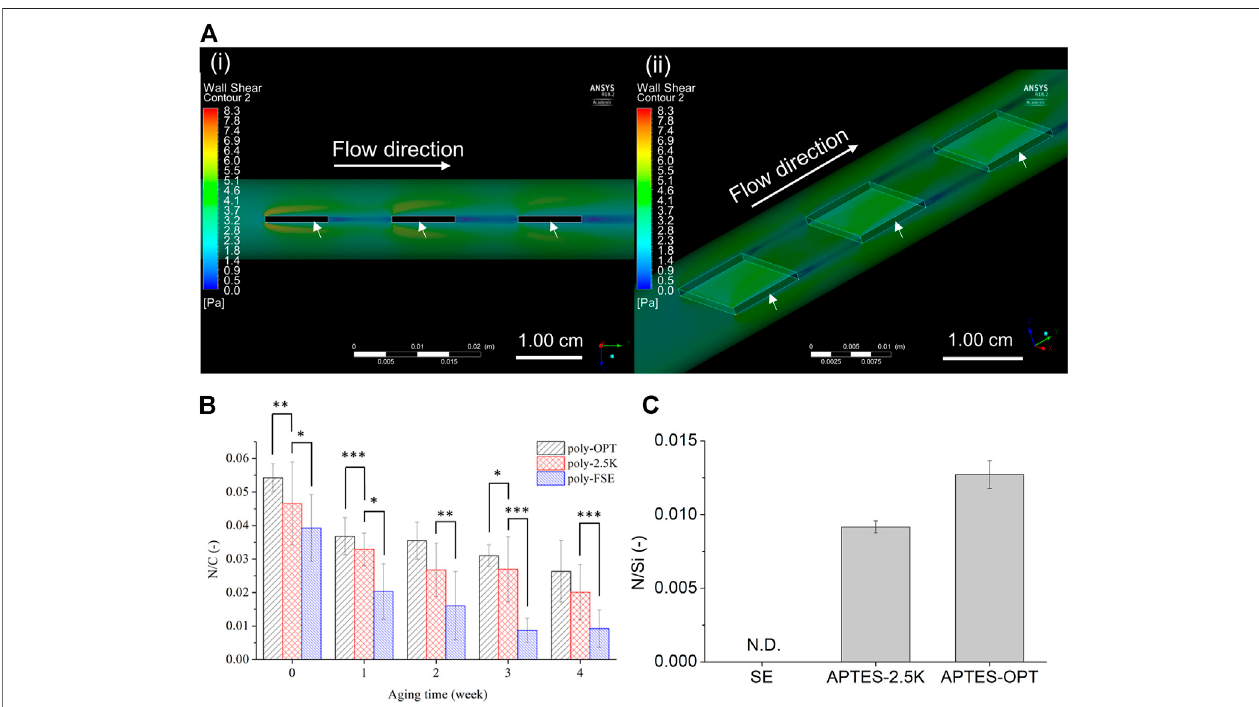
FIGURE6| Stabilityevaluationofthecoatedpolymer fi lmonthesiliconeelastomer(SE)sheetina fl uidiccirculatingsystem. (A) Colormapsforcrosssectionviewof side (i) and top view (ii) of wall shear stress (WSS) by computational fl uid dynamics (CFD) model in the tubing (inner diameter = 1.27 cm; outer diameter = 1.59 cm). The arrows indicate the SE sheets. The inlet fl ow rate was set as 8 L/min without outlet pressure. (B) The N/C (nitrogen comes from the polymer/carbon) ratio of the coated- polymer fi lm on oxygen plasma treated (poly-OPT), 2.5 K alkaline treated (poly-2.5K), and untreated (poly-SE sheets. The data was measured every week for one month.Resultsarepresented asmean±SD( n =6). * , **,and***denote p < 0.05, p < 0.01,and p < 0.001,respectively. (C) Evaluationofthesilanolgrouponthesurface of SE. The silanol group was reacted with APTES after treatment with 2.5 K (APTES-2.5K) and oxygen plasma (APTES-OPT), and then N/Si (nitrogen comes from APTES/silicon) was measured via XPS. Results are presented as mean ± SD ( n = 3).